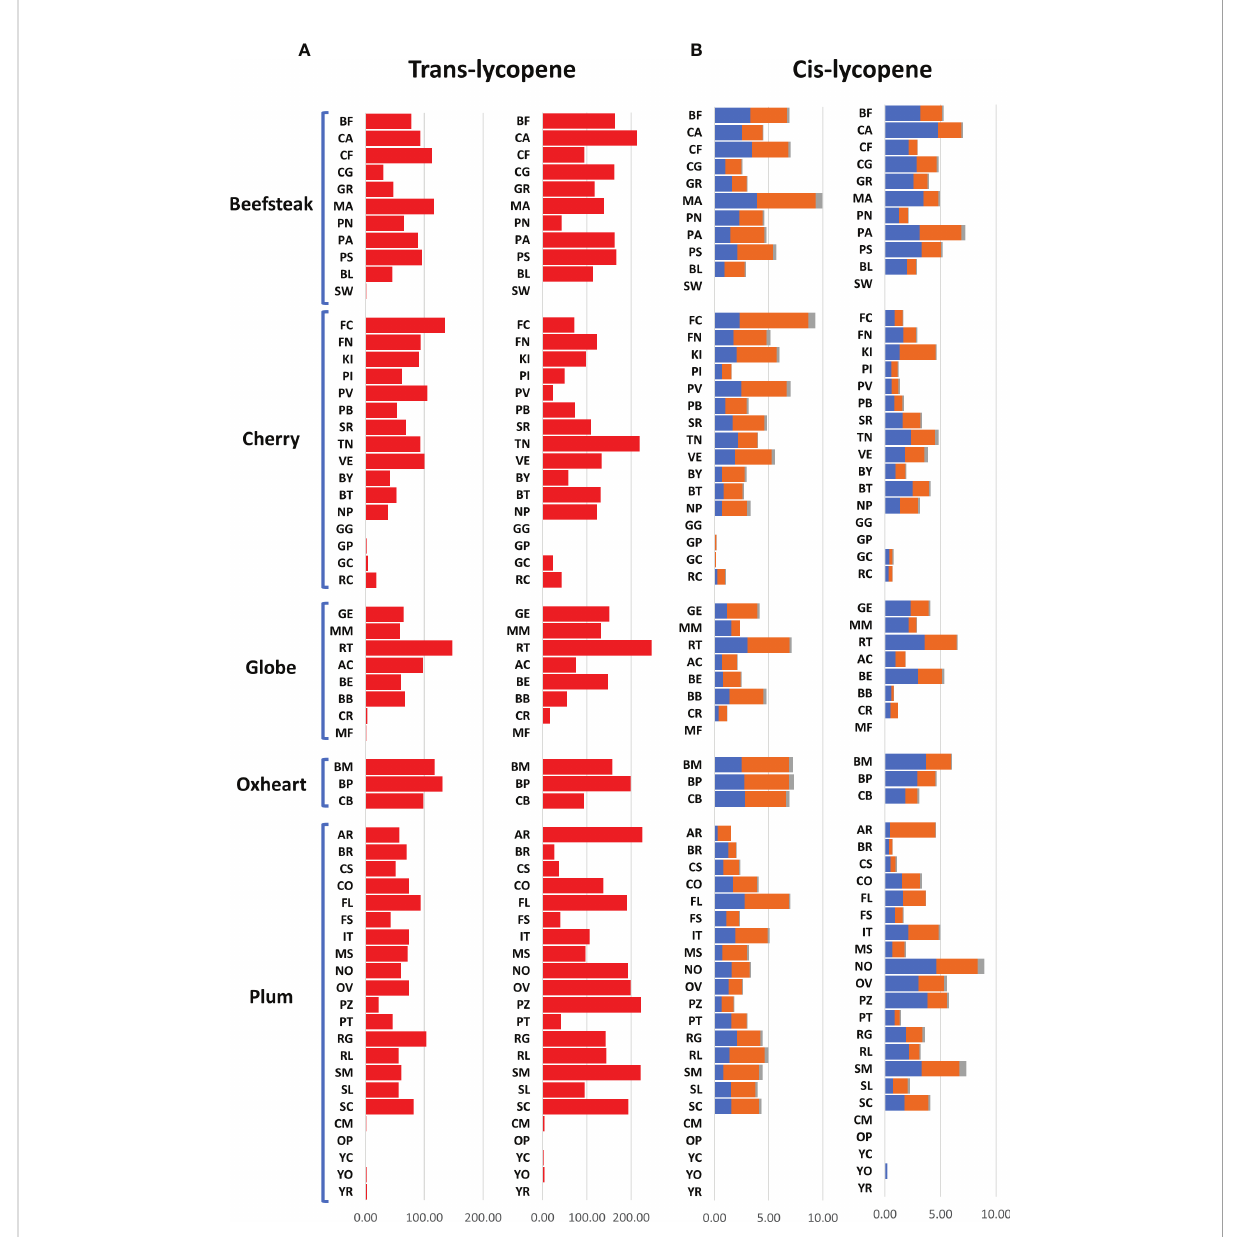
FIGURE 3 Variation for trans - and cis -lycopene in 60 heirloom genotypes in the 2 years of evaluation. Vertical bars show the average values for each accession. For each trait, data of the fi rst and the second seasons are on the left and the right, respectively. 9- Cis , 13- cis , and 15- cis lycopene are indicated in blue, orange, and gray colors, respectively. Genotypes are ordered based on cultivar group. Acronyms are listed in Supplementary Table